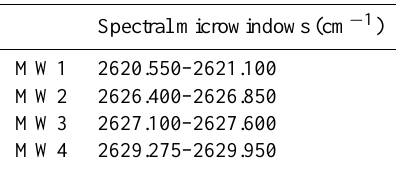
Table 1. Spectral microwindows chosen for the NDACC CO 2 re- trieval shown in this